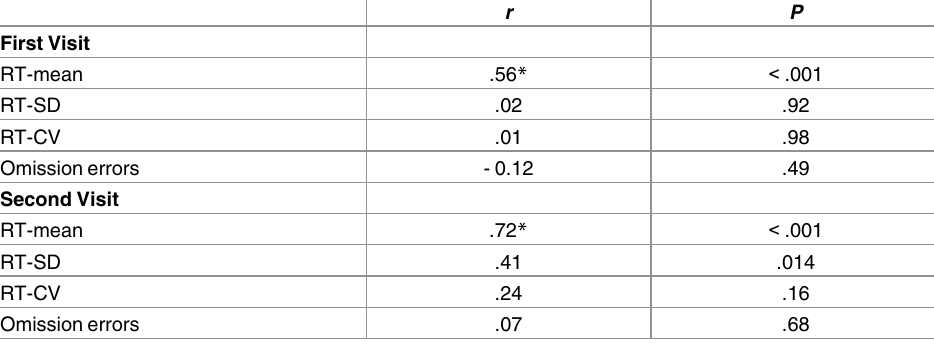
Table 5. Correlations ( r ) of conventional measurements between the Eriksen flanker task (EFT) and simple reaction task (SRT) for each visit. First Visit RT-mean .56 * < .001 RT-SD .02 .92